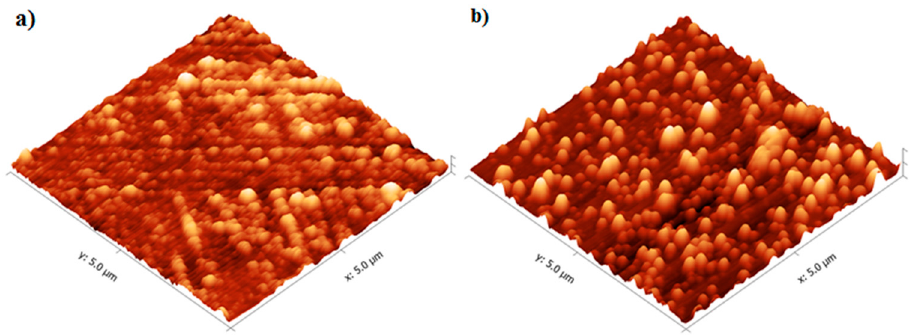
Figure 7. AFM Images of ( a ) 10 nm and ( b ) 50 nm TiO 2 films deposited at 200 °C. Table 1. Film thickness and roughness measurements of TiO 2 films deposited at 200 °C.